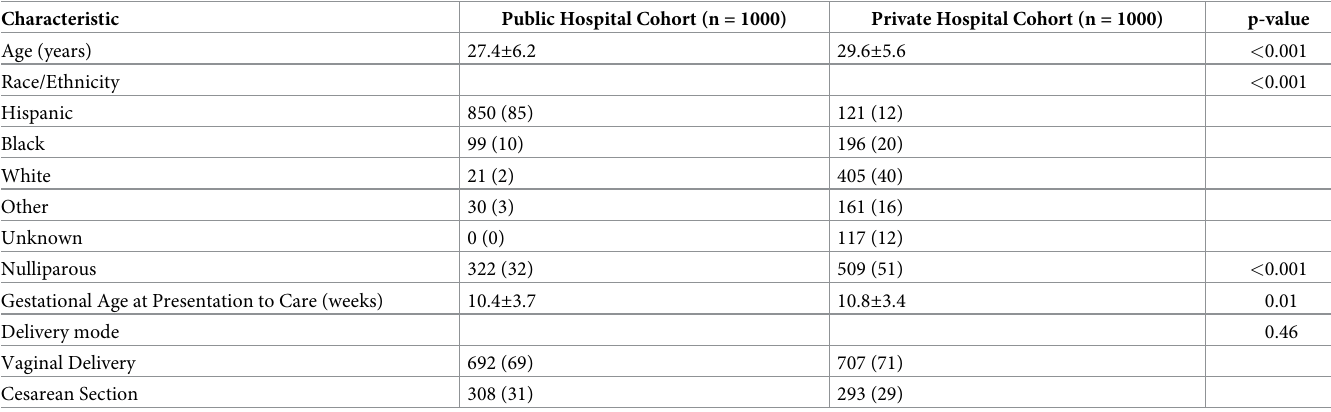
Table 1. Maternal demographics and obstetric